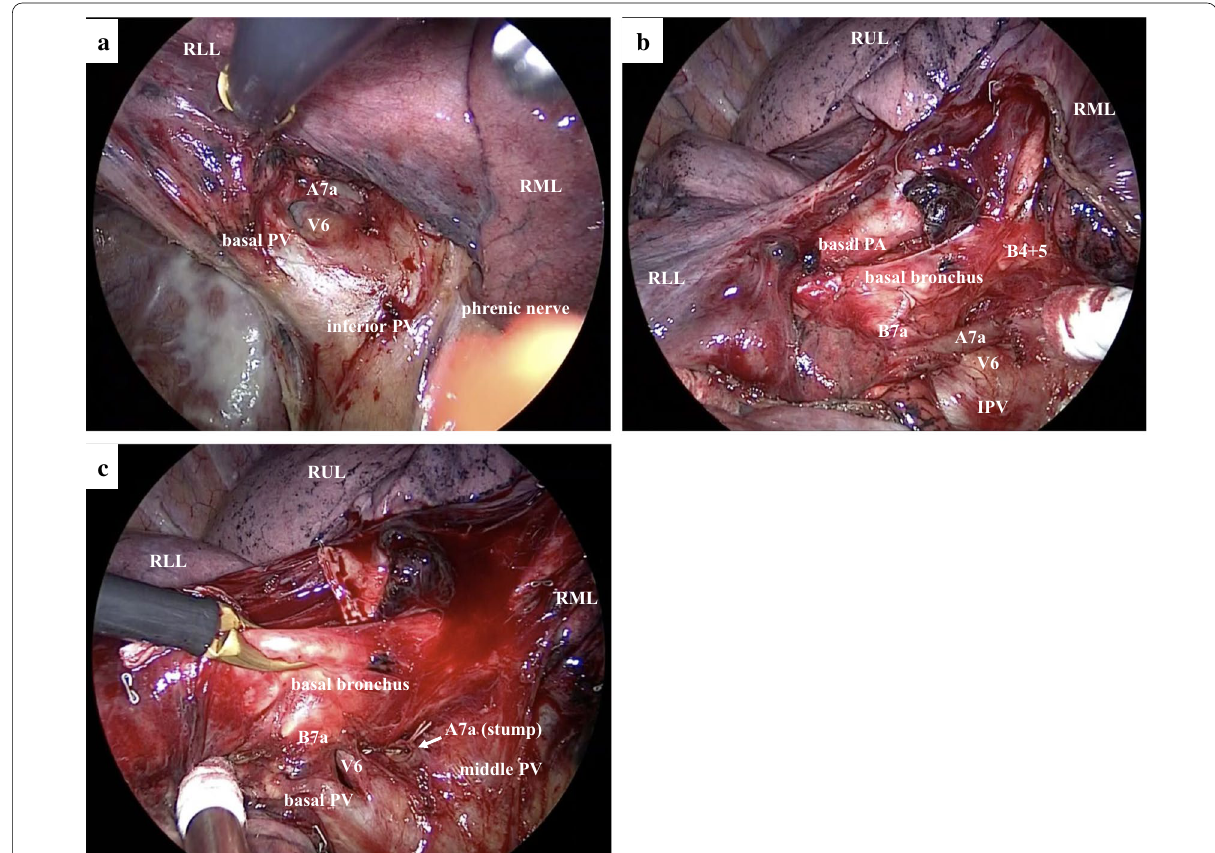
Fig. 3 Intraoperative findings. a An aberrant mediastinal A7a on the cranial side of V6. b After division of the interlobar lung parenchyma between RML and RLL. c After dissection of the aberrant mediastinal A7a. PV pulmonary vein; RLL right lower lobe; RML right middle lobe; RUL right upper